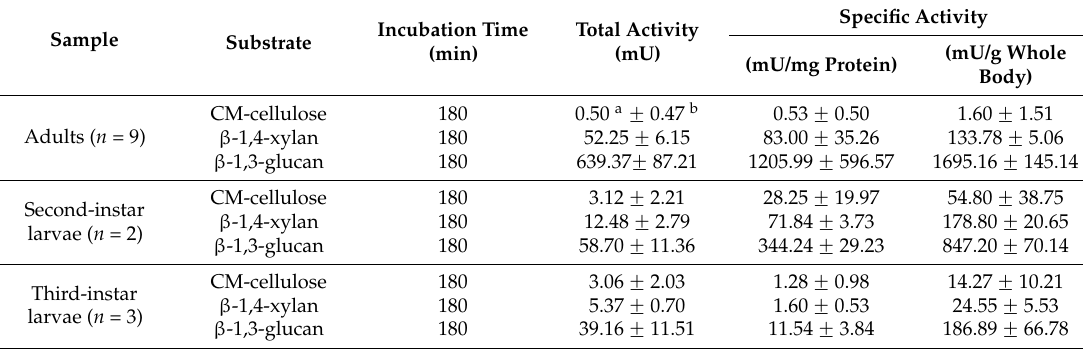
Table 2. Glycanase activities in whole bodies of Cylindrocaulus patalis